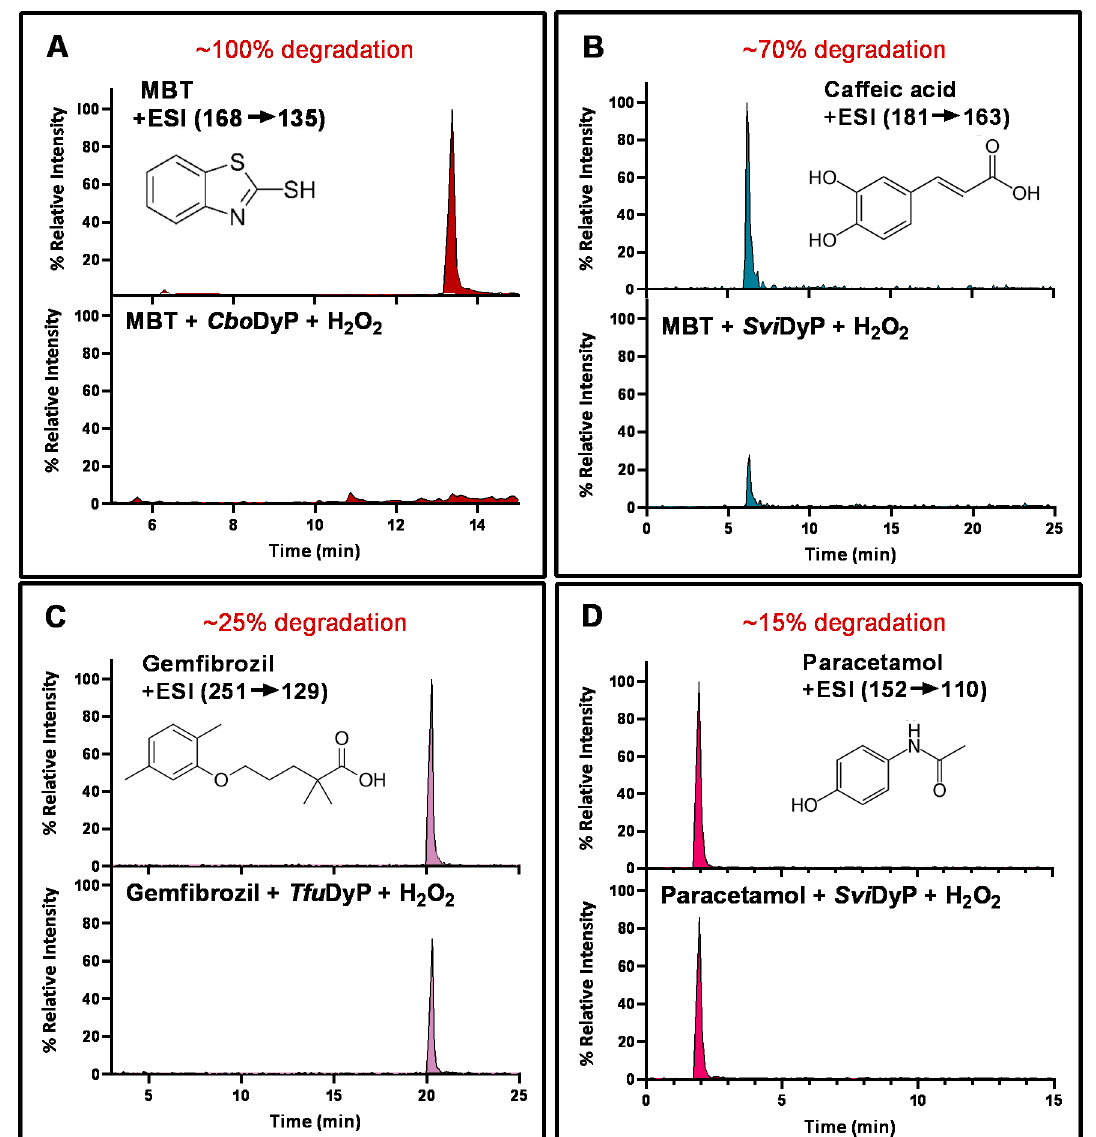
Figure 4. ( A ) MRM chromatograms of MBT untreated and treated samples with Pf DyP B2, Tfu DyP, Cbo DyP and Svi DyP. ( B ) Percentage of MBT remaining upon degradation by Pf DyP B2, Tfu DyP, Cbo DyP and Svi DyP. Reaction conditions: [EP] = 4 ppm, [ Pf DyP B2] = 0.255 μ M, [ Tfu DyP] = 0.087 μ M, [ Cbo DyP] = 4.33 μ M, [ Svi DyP] = 2.8 μ M, [H 2 O 2 ] = 0.25 mM, pH values for Pf DyP B2, Tfu DyP, Svi DyP, and Cbo DyP are 3, 4, 4, and 5, respectively. Insets in the Cbo DyP and Svi DyP pan- els show zoomed in chromatograms with the red asterisk showing the residual MBT. ** p < 0.01 *** p < 0.001 compared to the “Control”.